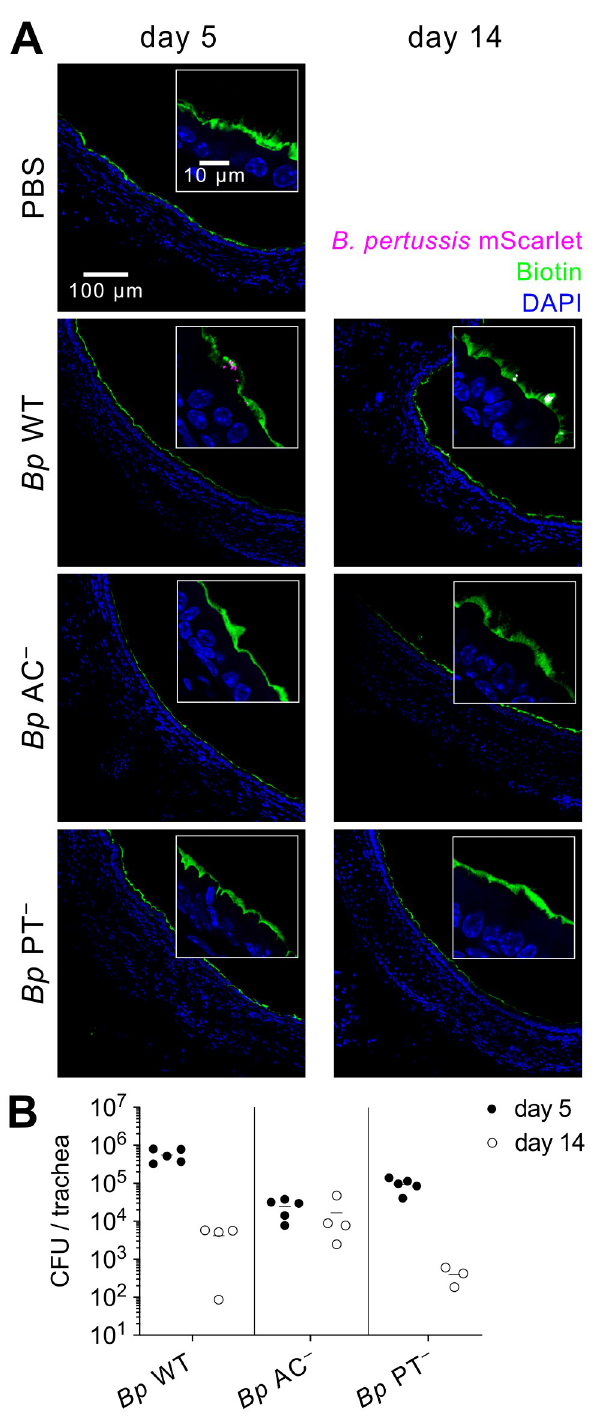
Fig 3. Bp PT − does not cause enhanced disintegration of airway epithelial lining. (A) Tracheal epithelial lining of infected mouse lungs on day 5 (left panel) and day 14 (right panel). At indicated time points, the epithelial lining of the airways of mice was labeled in vivo by intranasal administration of 50 μ l NHS biotin (1 mg/ml) for 5 minutes before the animals were euthanized. Respiratory tracts were fixed with 4% PFA, snap frozen and 10 μ m transversal cryosections of tracheas were labeled with Alexa Fluor 488 streptavidin conjugate. Nuclei were visualized by DAPI staining. Images were acquired using a Leica TCS SPE confocal microscope. Biotin, nuclei and bacteria are rendered in